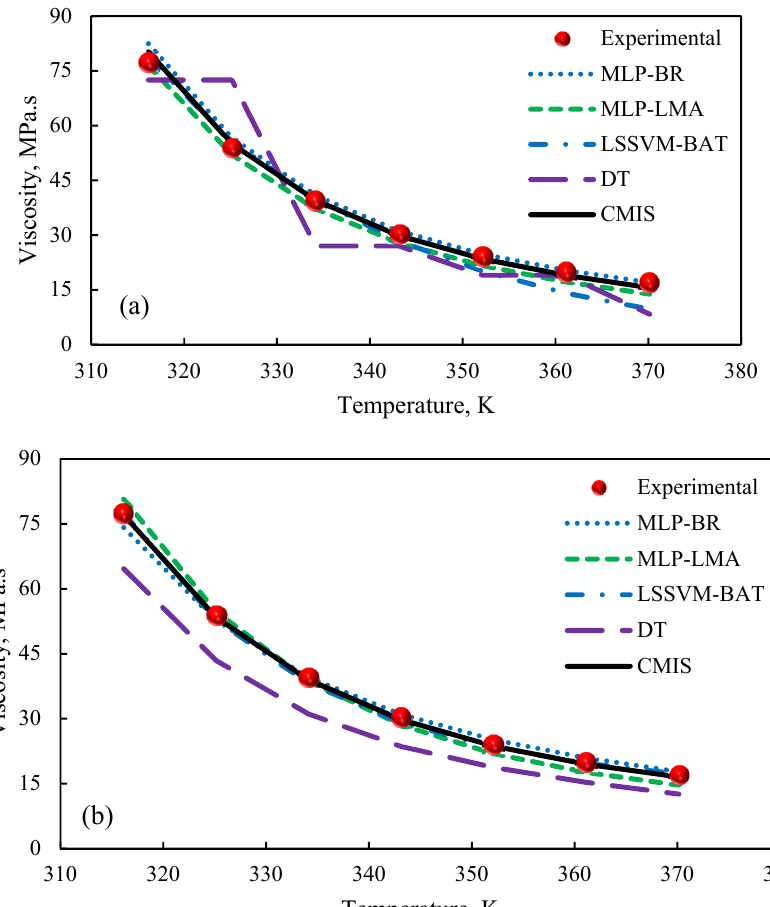
Figure 15. Effect of temperature on 1-ethyl-3-methylimidazolium ethylsulfate. ( a ): Model (II); ( b ): Model (III).